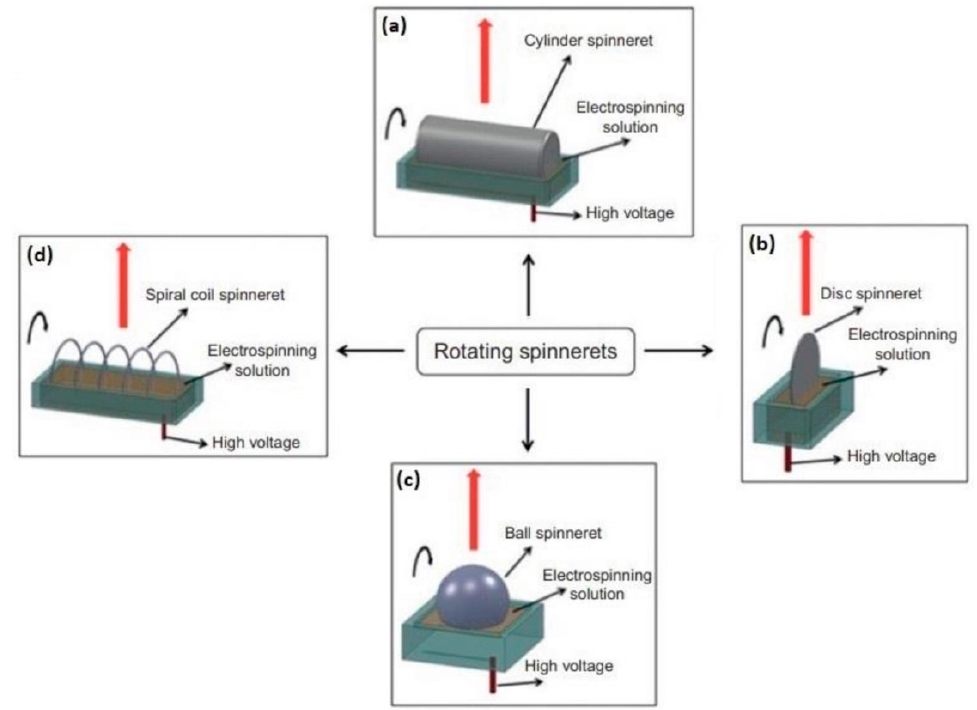
Figure 5. Schematic diagram depicting the rotating spinnerets: cylindric spinneret ( a ), disc spinneret ( b ), ball spineret ( c ), and wire/coil spinneret ( d ) in needleless electrospinning (upward electrospinning direction along the red arrow) [90] .